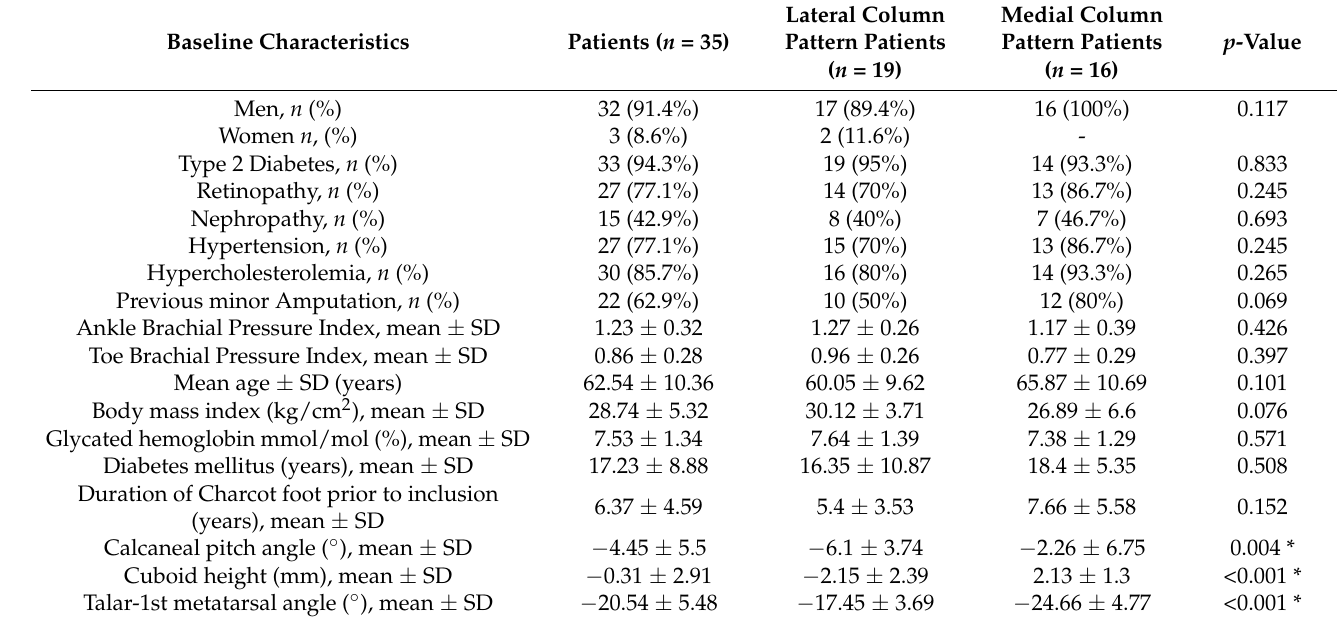
Table 1. Differences between the risk factors for lateral and medial Charcot midfoot patterns.